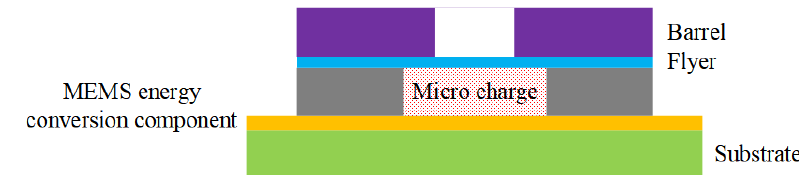
Figure 2. Schematic view of flyer driven by micro ‐ charge detonation.